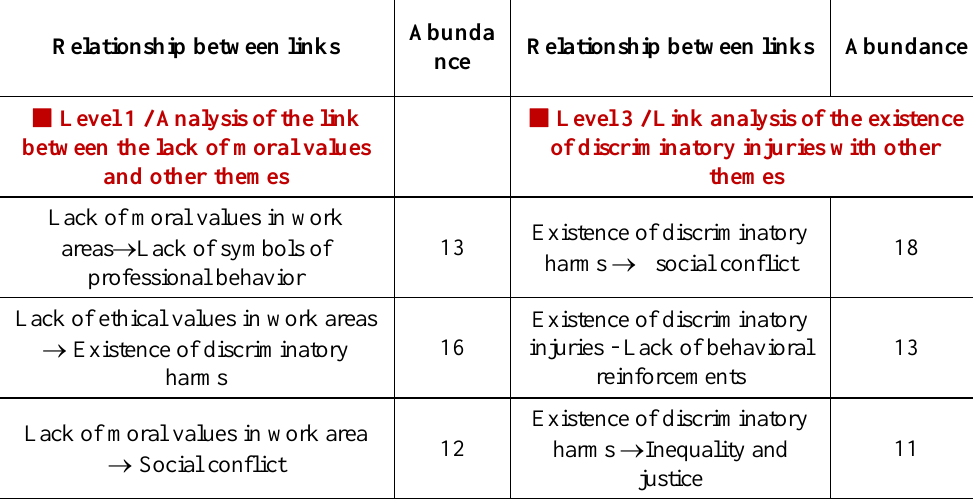
Table 6. Affinity Relationship Links (ARL) between components Abunda Relationship between links Relationship between links Abundance nce  Level 1 / Analysis of the link between the lack of moral